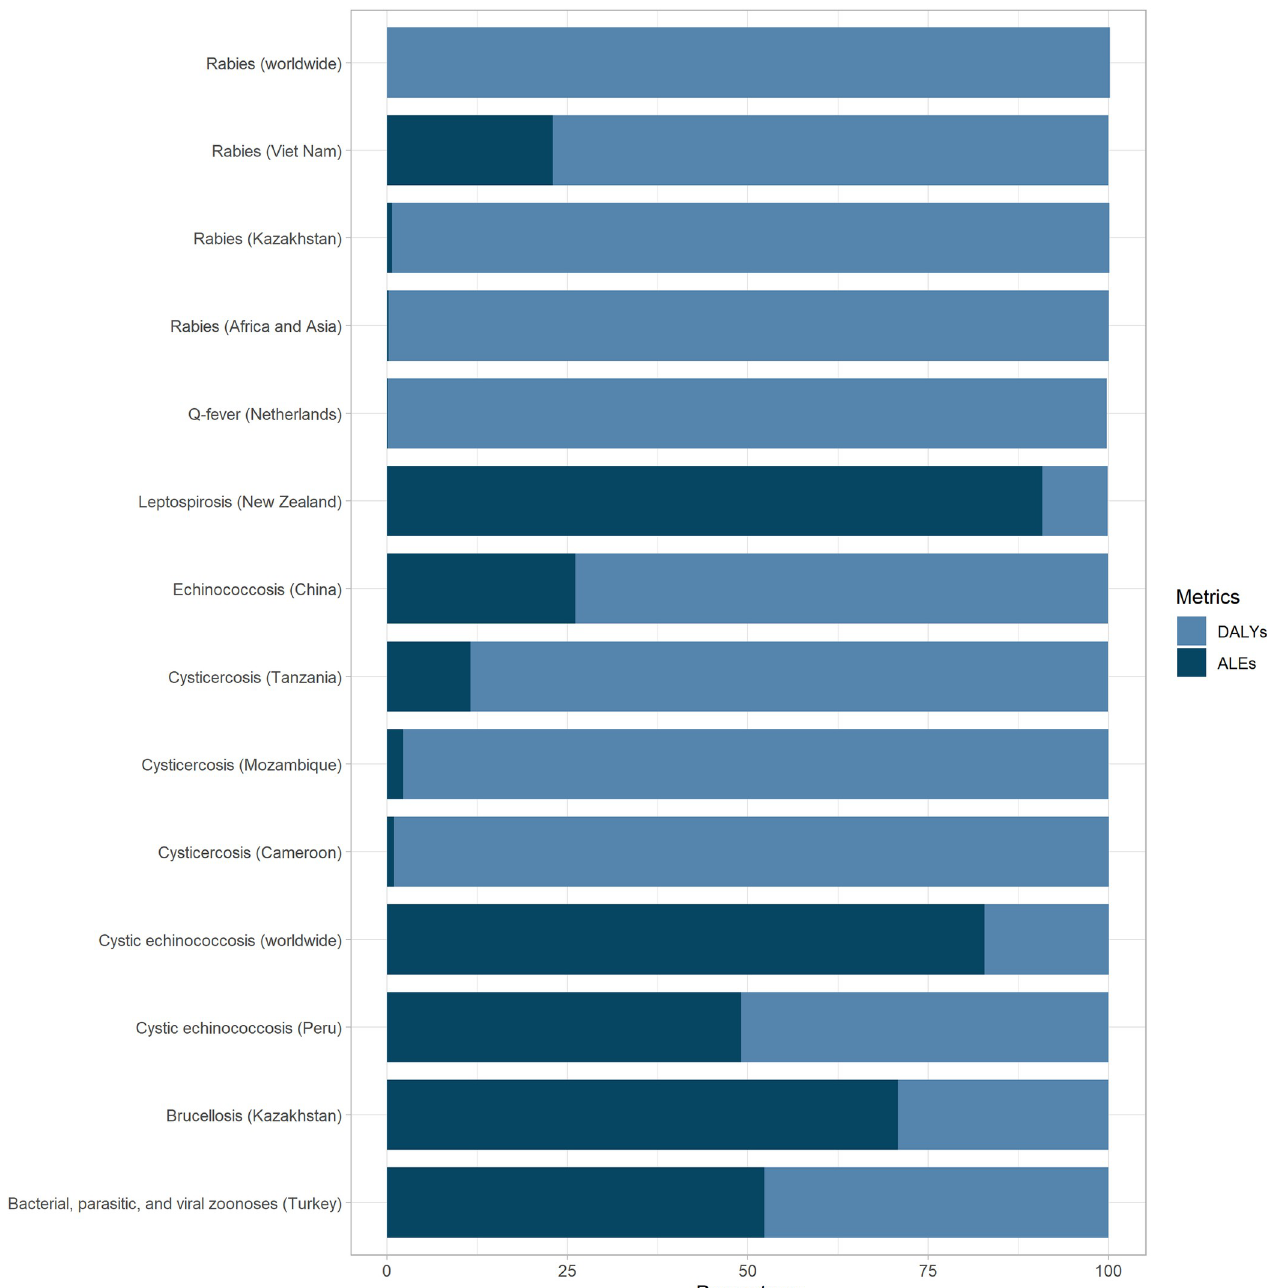
Fig 3. Relative distribution of the DALYs and ALE among the